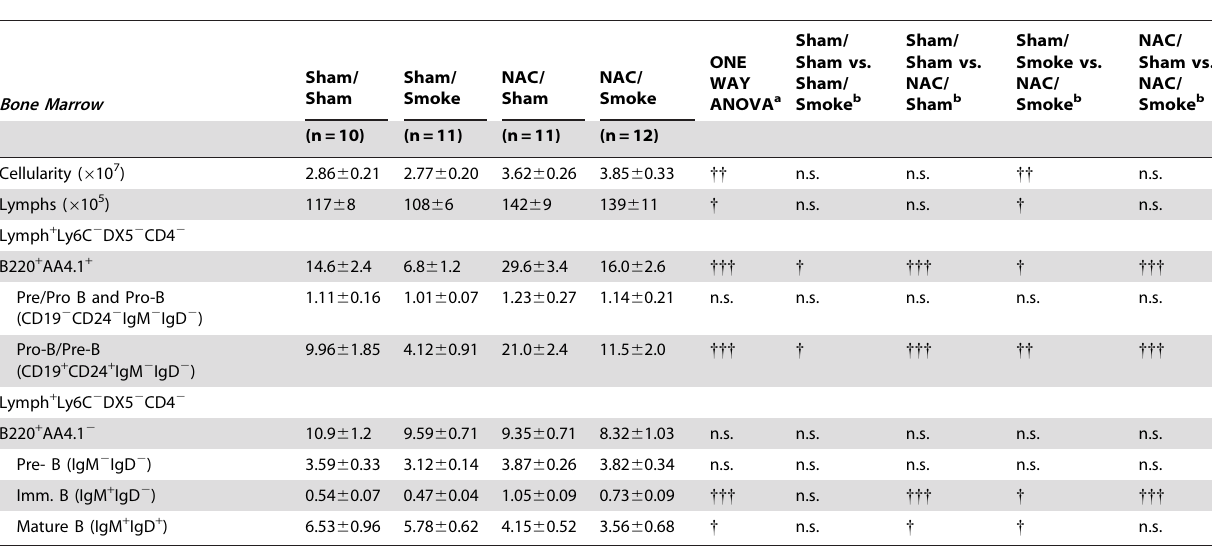
Table 1. Summary of total cell counts of various B cell subsets ( 6 10 5 unless indicated).